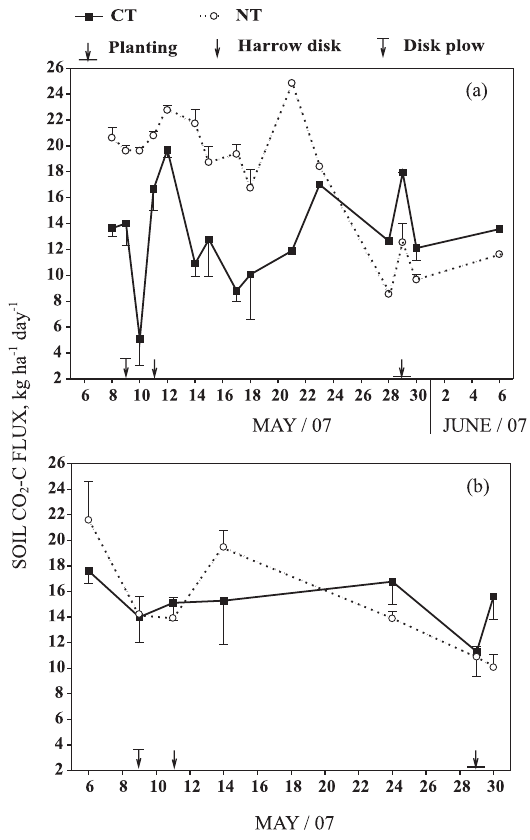
Figure 2. Soil CO -C flux in conventional tillage (CT) 2 and no-tillage (NT) systems measured in dynamic chamber (a) and static chamber (b). Vertical bars represent the mean standard